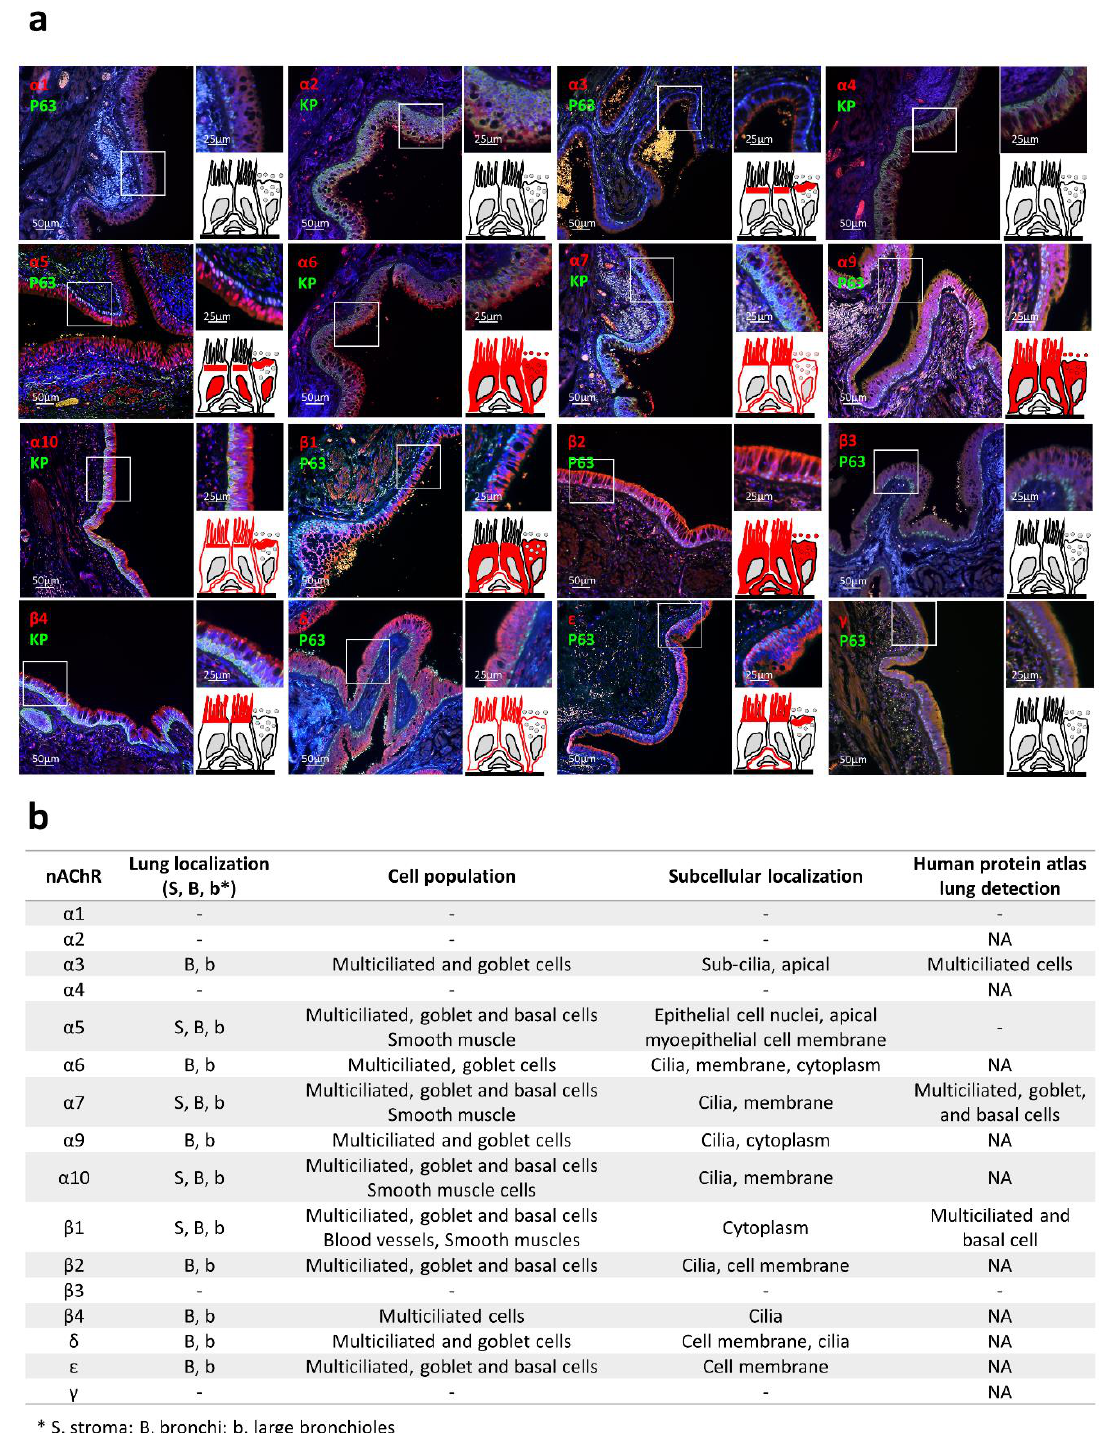
Figure 5. nAChR localizations in human respiratory epithelia. ( a ) Representative micrographs showing the bronchial epithelia on formalin-fixed paraffin-embedded (FFPE) lung tissues stained for the nAChRs (all red), non-differentiated cells (p63 or pan-cytokeratin, green), and cell nuclei (DAPI, blue). Magnification corresponding to the selected area is shown. Drawings depict the localization of each nAChR subunit (in red). ( b ) Table summarizing nAChR subunit cellular and sub-cellular localization and the available microscopic data from the Human Protein Atlas (https://www.proteinatlas.org/). NA, not available; -, no detection.